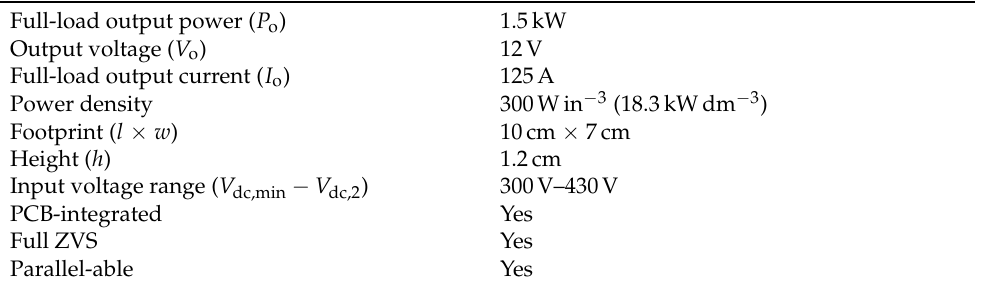
Table 1. DC/DC module design